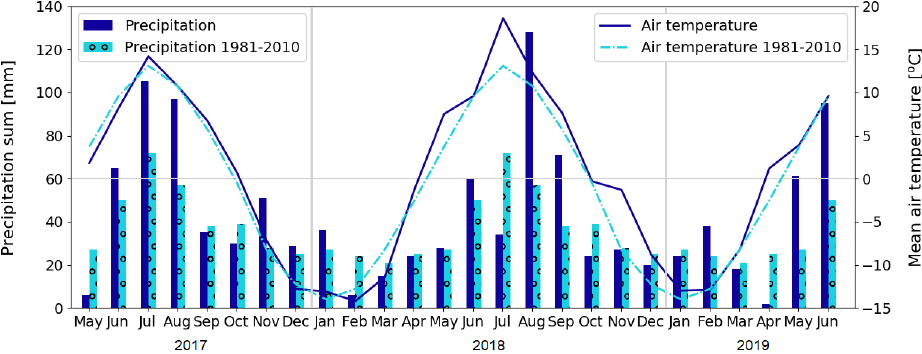
Figure 3. Monthly precipitation sum and mean air temperature at Kaamanen, and the corresponding 30-year averages (Pirinen et al., 2012) measured at the Ivalo weather station (68 ◦ 36 (cid:48) N, 27 ◦ 25 (cid:48) E; 59km south of